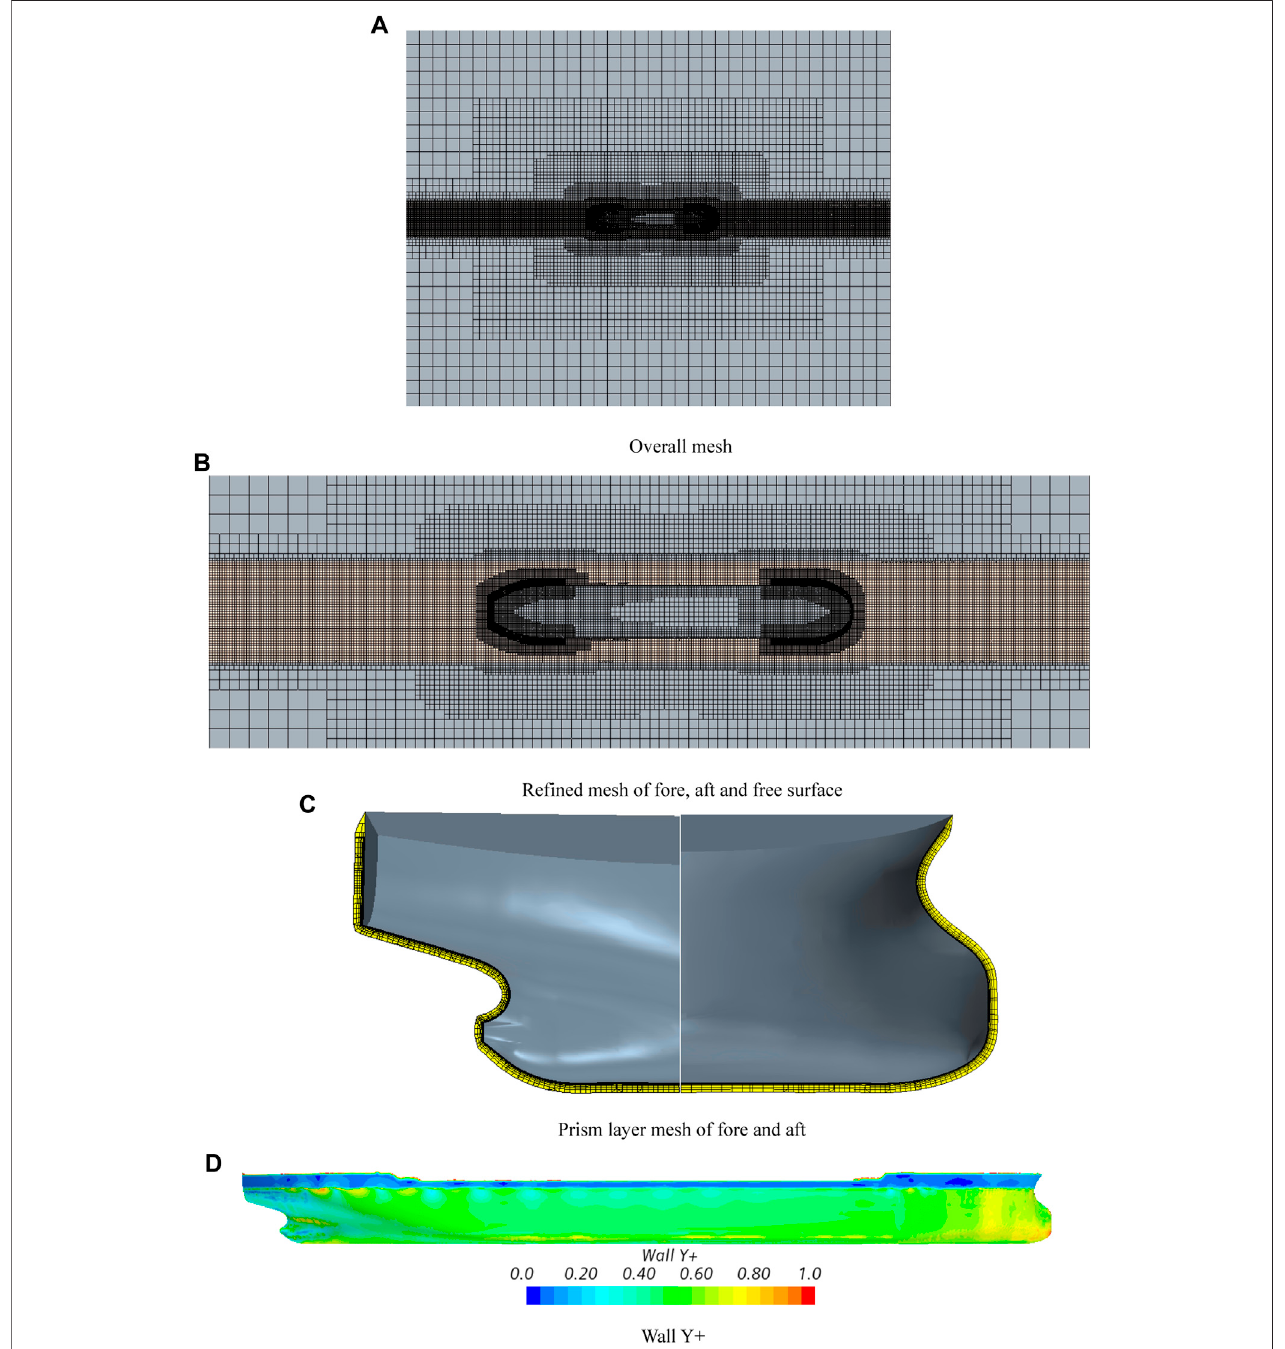
FIGURE 4 | Computational domain mesh and wall